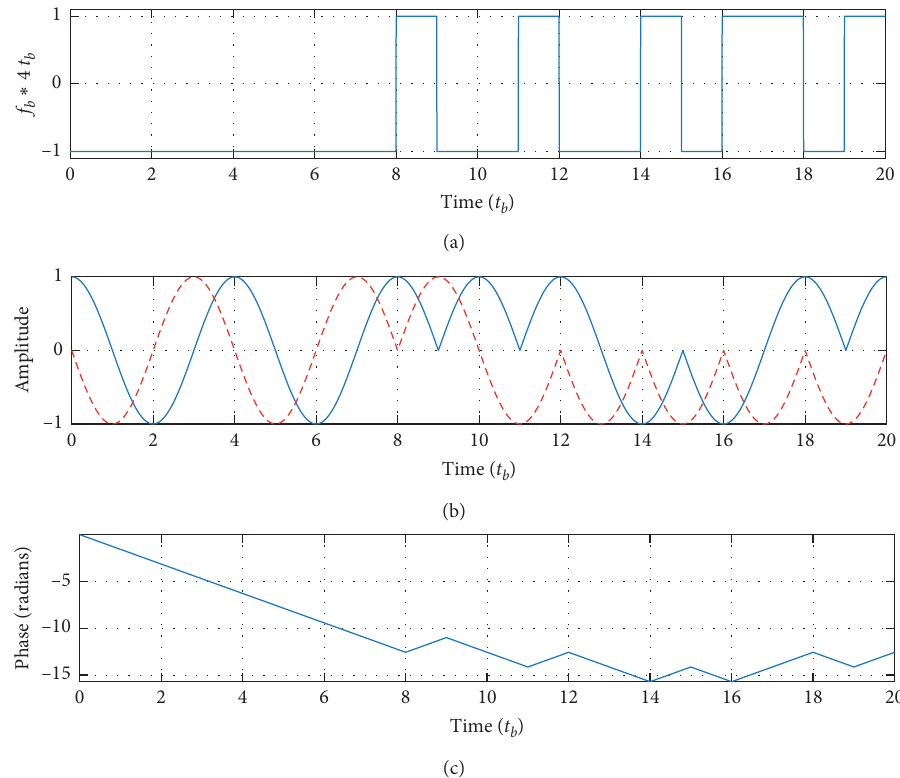
Figure 19: One pulse of a two-valued frequency-coded waveform: (a) a 20-chip two-valued frequency code, i.e., [0 0 0 0 0 0 0 01 0 01 0 01 01 1 0 1], (b) the I / Q of the waveform (solid and dashed lines are I and Q , respectively), and (c) the phase in each chip of the